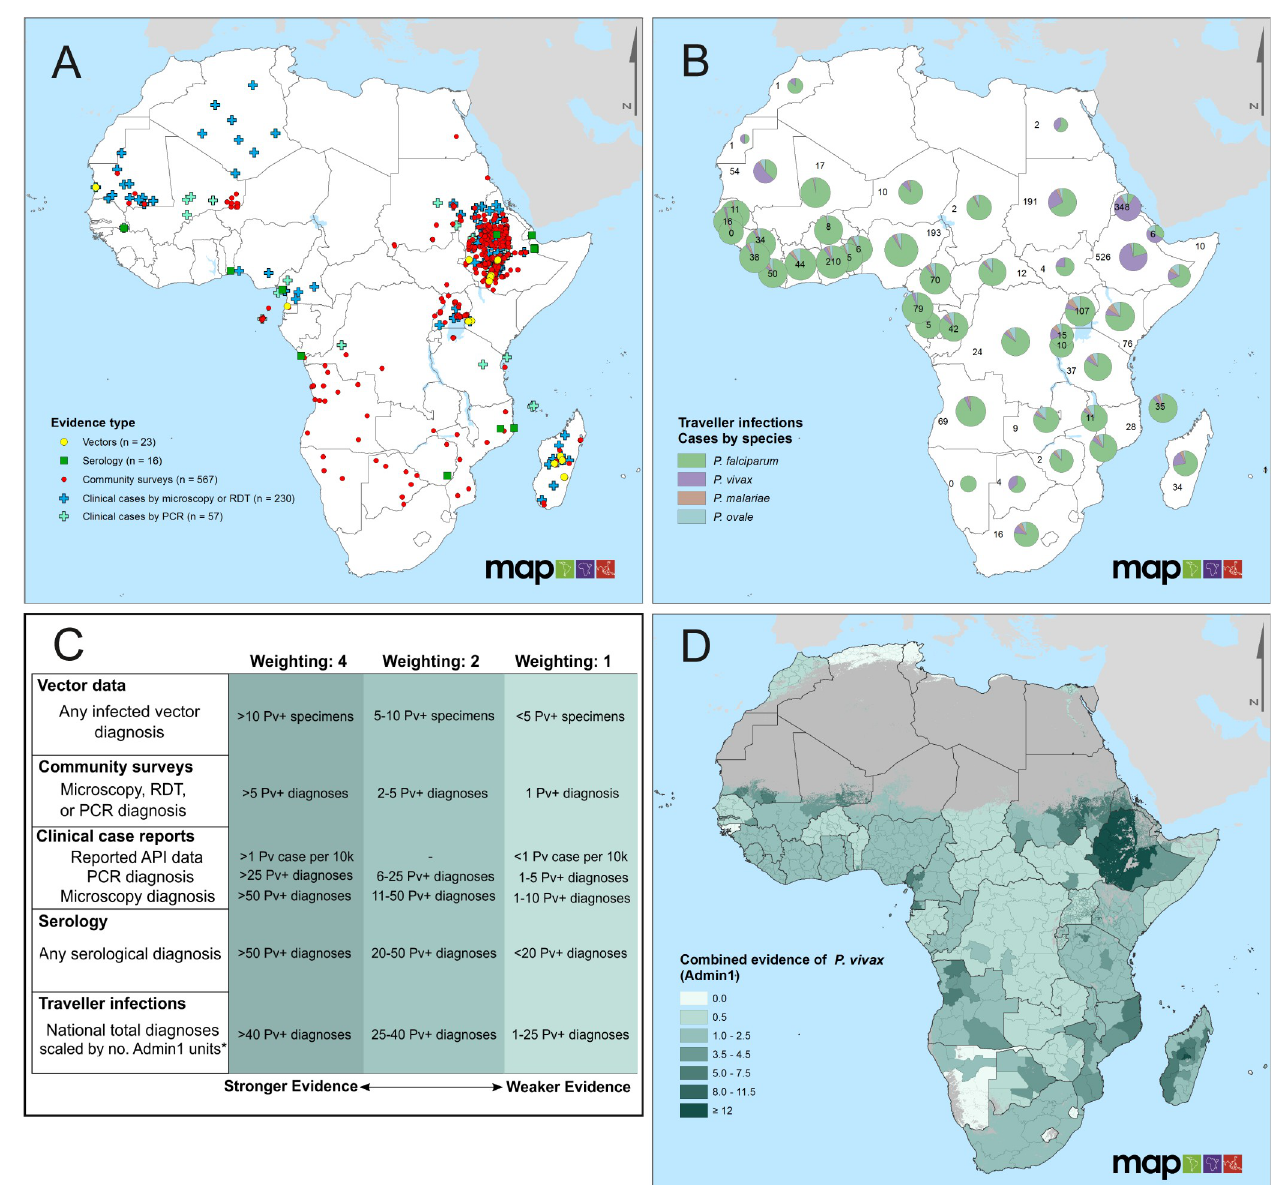
Fig 1. Evidence of P . vivax in Africa. Panel A maps all available reports of P . vivax occurrence (n = 657 unique sites) by evidence type (1980–2016). Data from Howes et al . [14] are combined with the results of this update (new points are shown in S4 Fig). Panel B summarises exported malaria infections among travellers returning to non-endemic countries, grouped by suspected country of origin and Plasmodium species. Pie charts represent the proportional contribution by malaria species, sized based on a log-transformation of the total number of infections. The numbers shown beside each pie chart refer to the number of P . vivax infection reports attributed to each country. The traveller infections database represents an opportunistic assembly of reports, and does not aim to be comprehensive; reports are aggregates of data from 1991 to 2016, see S3 Fig for timespan of input data. Panel C documents the framework used to weight the data from Panels A and B to characterise the strength of evidence of local P . vivax transmission. Evidence weights (top row) were assigned for each evidence type in each Admin1 unit (state/province), and summed to indicate the total evidence of P . vivax in a given unit. The resulting composite evidence map is shown in Panel D. Darker shading indicates increased evidence of the presence of P . vivax . White indicates units for which no evidence was found (evidence strength = 0), and grey shading indicates regions where environmental conditions are unsuitable for P . vivax transmission [22]. � National reported infections among returning travellers were scaled by the total number of Admin1 units in a given country. For countries with fewer traveller P . vivax cases than Admin1 units, a weighting of 0.5 was given to each admin unit.